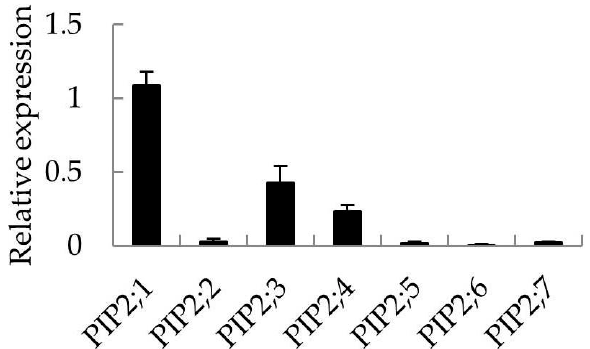
Figure 5. Transcriptional profiling of seven PIP2 genes in the root of M. hupehensis . RNA was extracted from the roots of hydroponically-raised M. hupehensis seedlings which had formed 7–8 true leaves. Values show in the form mean ± SD ( n = 3).